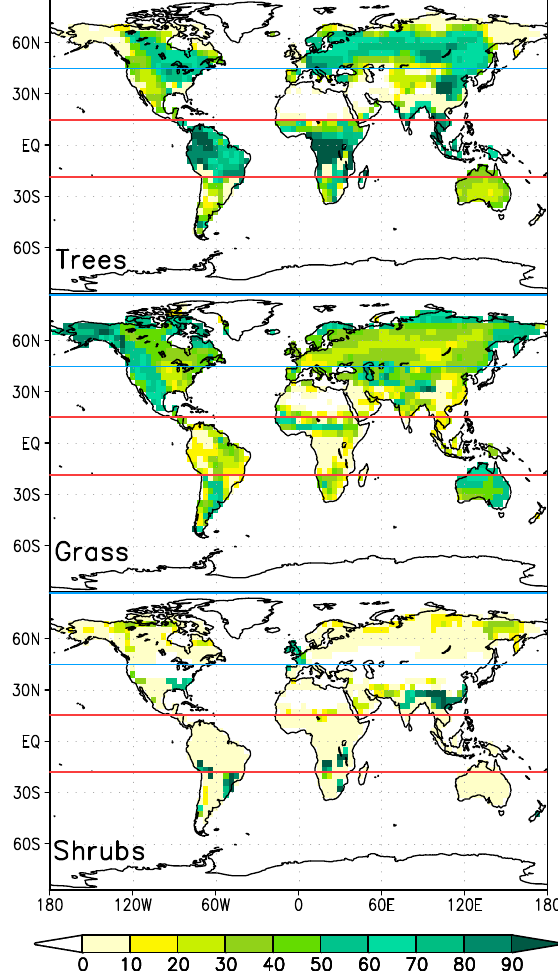
Fig. 1. Distribution of natural potential trees, grass and shrubs in the control experiment. Displayed is the fraction of each grid cell cov- ered by the according vegetation. The blue and red lines contain the areas affected in the boreal and tropical experiments,